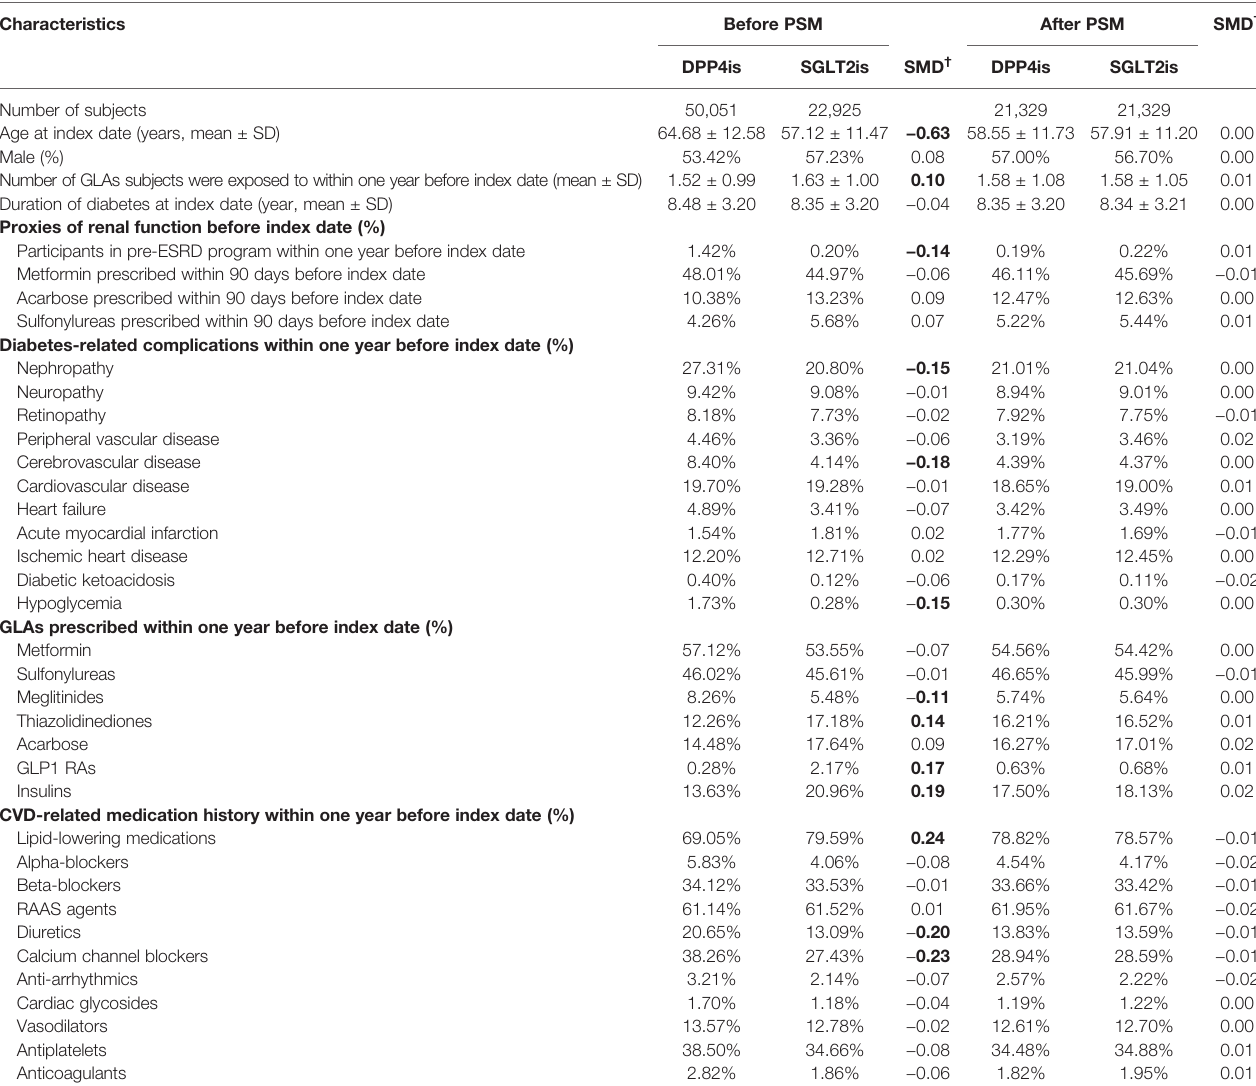
TABLE 1 | Baseline characteristics of study population strati fi ed by study drugs (SGLT2is and DPP4is) before and after propensity score matching.